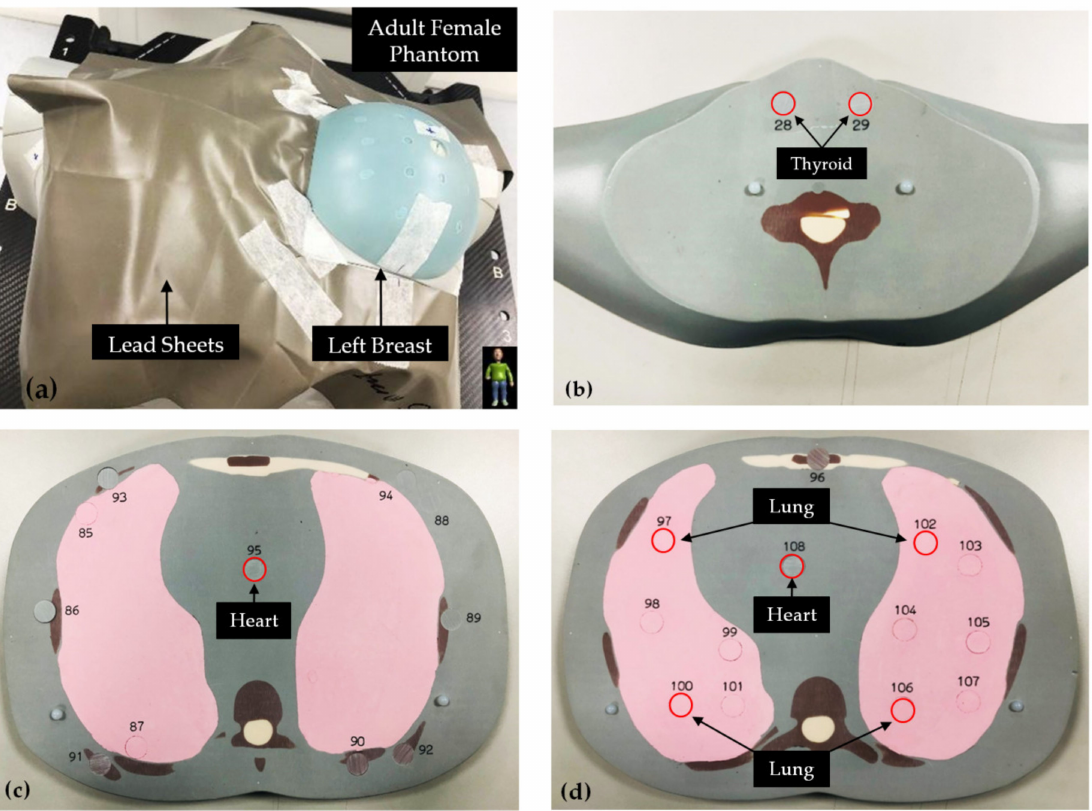
Figure 4. The CIRS ATOM phantom with the locations of nanoDot OSL dosimeters labeled and associated with organs. ( a ) The adult female phantom with the skin around the left breast covered by lead shields. ( b ) Thyroid measurement points No. 28 and 29. ( c ) Heart measurement point No. 28; ( d ) Heart measurement point No. 108 and lung measurement points 97, 100, 102, and